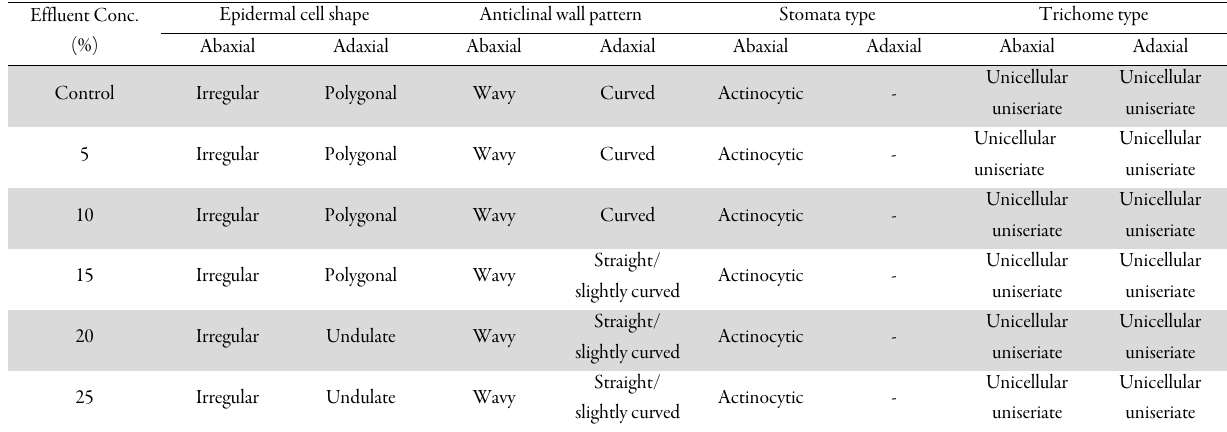
Table 8. Qualitative foliar characters of the studied Solanum lycopersicum treated with different concentrations of effluent Effluent Conc.